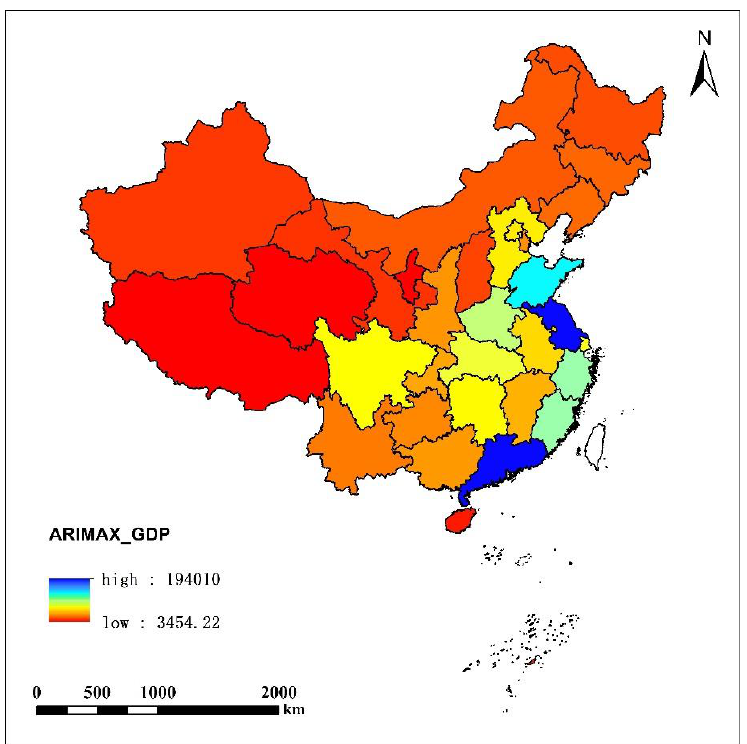
Figure 11. The 2030 GDP forecast of Chinese provinces (except Taiwan) using the ARIMAX model.